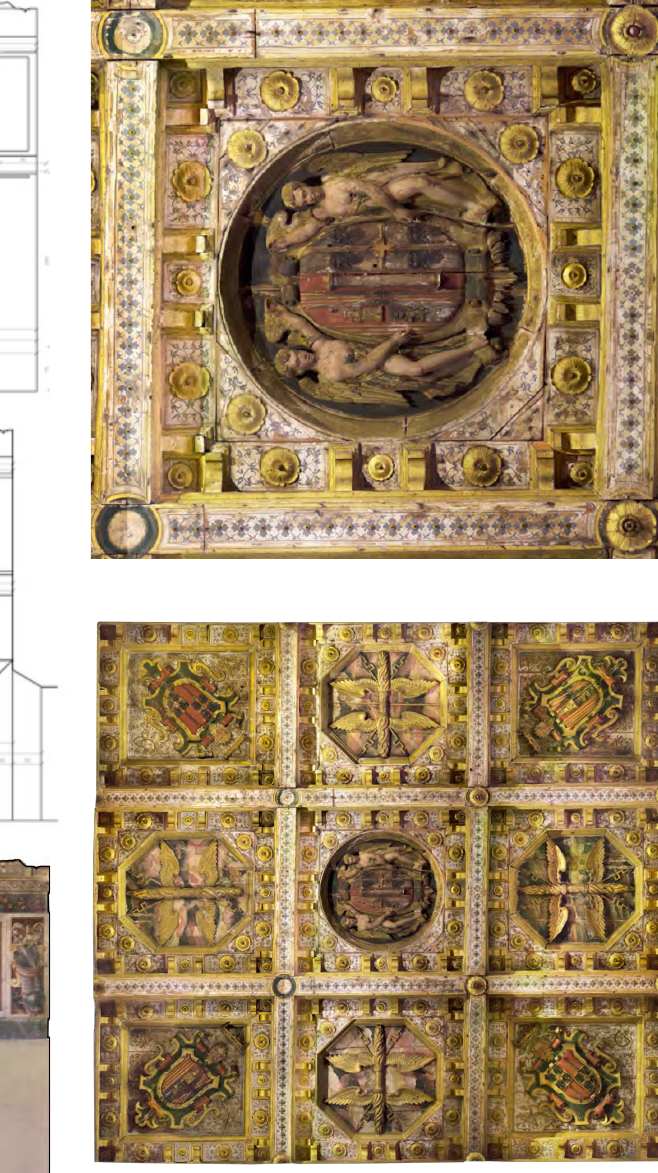
Figure 9. Details of the ceiling coming from Photoscan projections